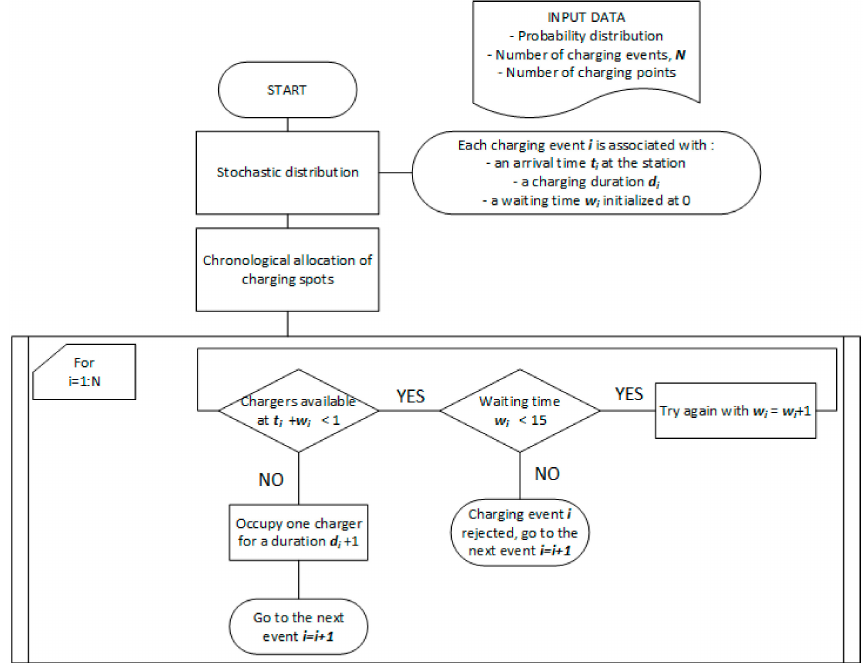
Figure 2. Queuing algorithm